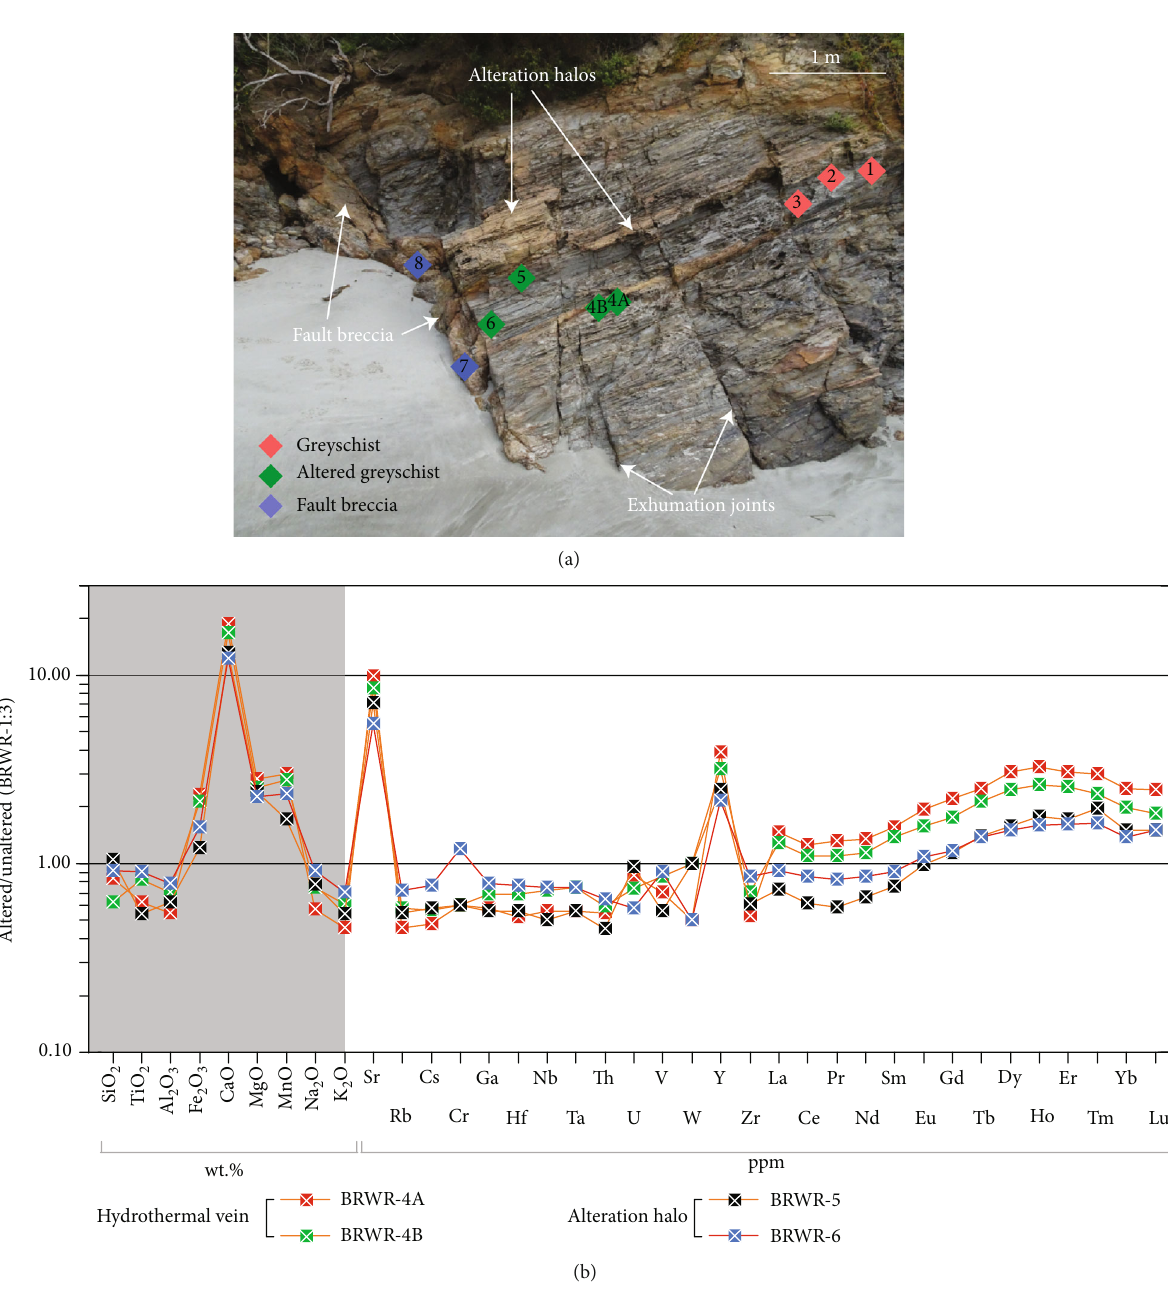
Figure 7: Whole-rock mass-balance calculations. (a) Outcrop at Bruce Rocks where samples were collected from unaltered grayschist (samples 1-3), altered greyschist from within carbonate alteration zones (samples 4-6), and fault breccia (samples 7-8). (b) Whole-rock geochemistry of the altered greyschist compared to the average of three unaltered greyschist samples (BRWR-1:3). Values higher than one are gained during alteration, and anything below one has been lost. The fi gure shows mobilization of Fe together with Sr, Y, and